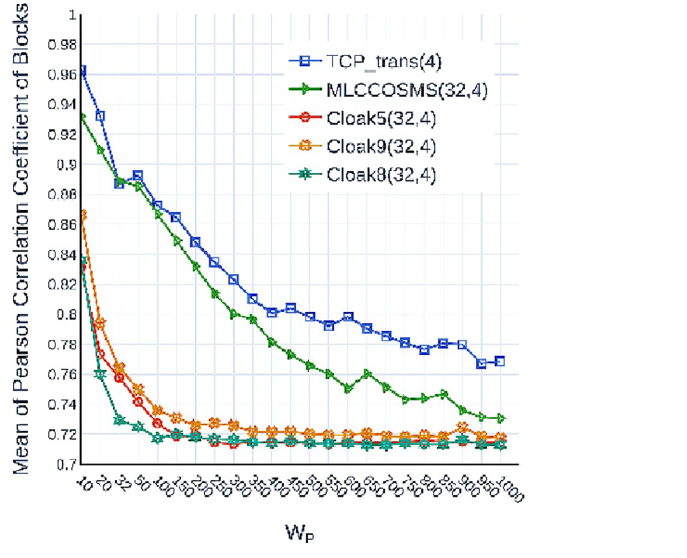
Fig 8. Mean of the Pr